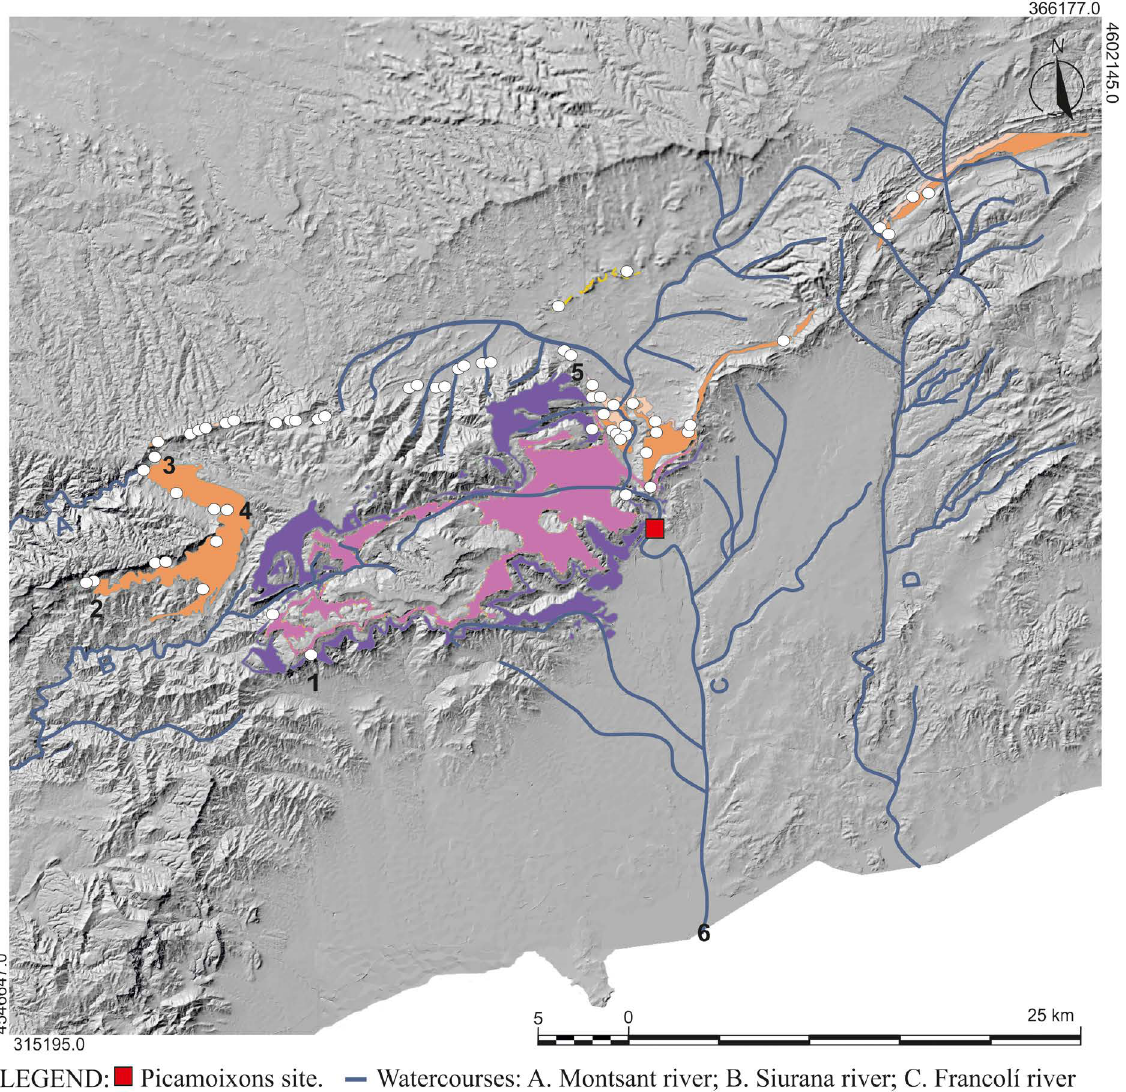
Figure 4. General map of the prospected area